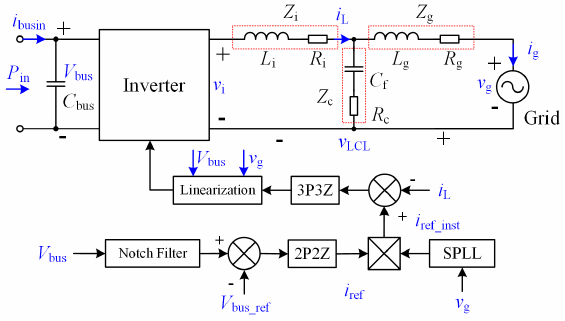
Figure 2. Control structure of the inverter.